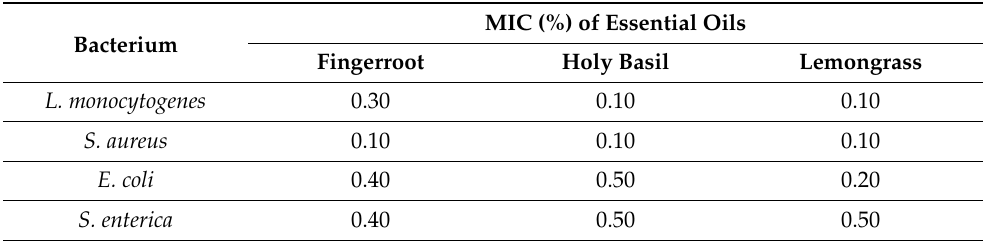
Table 1. Minimum inhibitory concentrations (MICs) of various essential oils against L. monocytogenes , S. aureus , E. coli and S. enterica determined by agar dilution method.